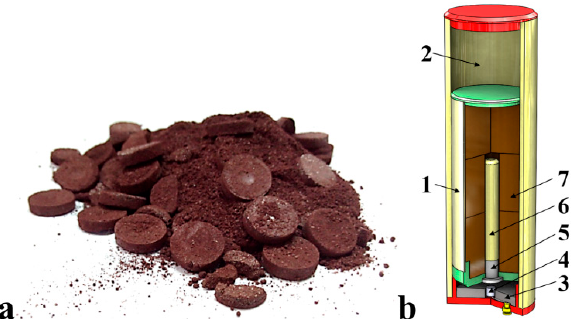
Figure 1. ( a ) RP smoke load and ( b ) SGD representation: 1—SGD body, 2—launcher tube, 3—gun powder, 4—electric igniter, 5—delay device, 6—central booster with gun powder, 7—RP smoke load.